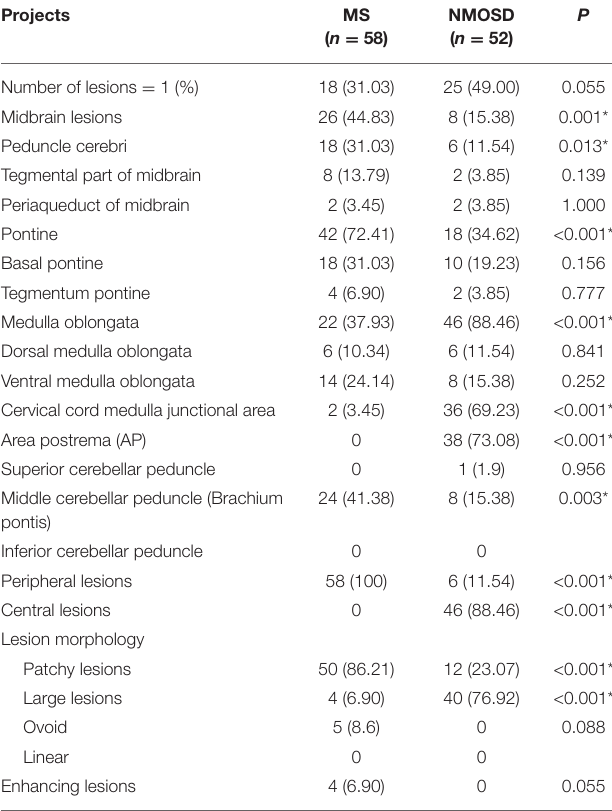
TABLE 3 | MRI features of